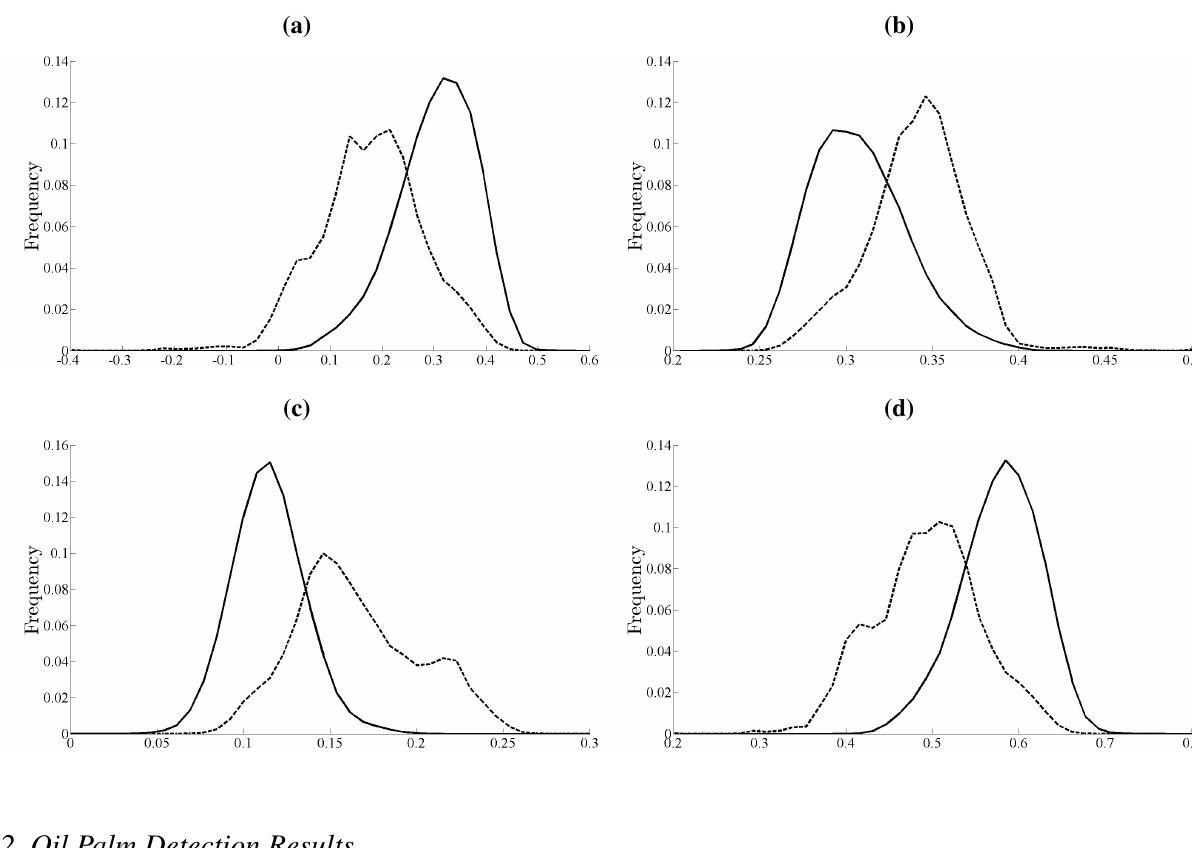
Figure 3. The histograms of candidate vegetation indices using QuickBird imagery.using QuickBird imagery. The histogram of oil palm tree is plotted with the solid line while background is plotted with the dashed line: ( a ) Green normalized difference vegetation index, ( b ) Normalized green, ( c ) Normalized red and ( d ) Normalized